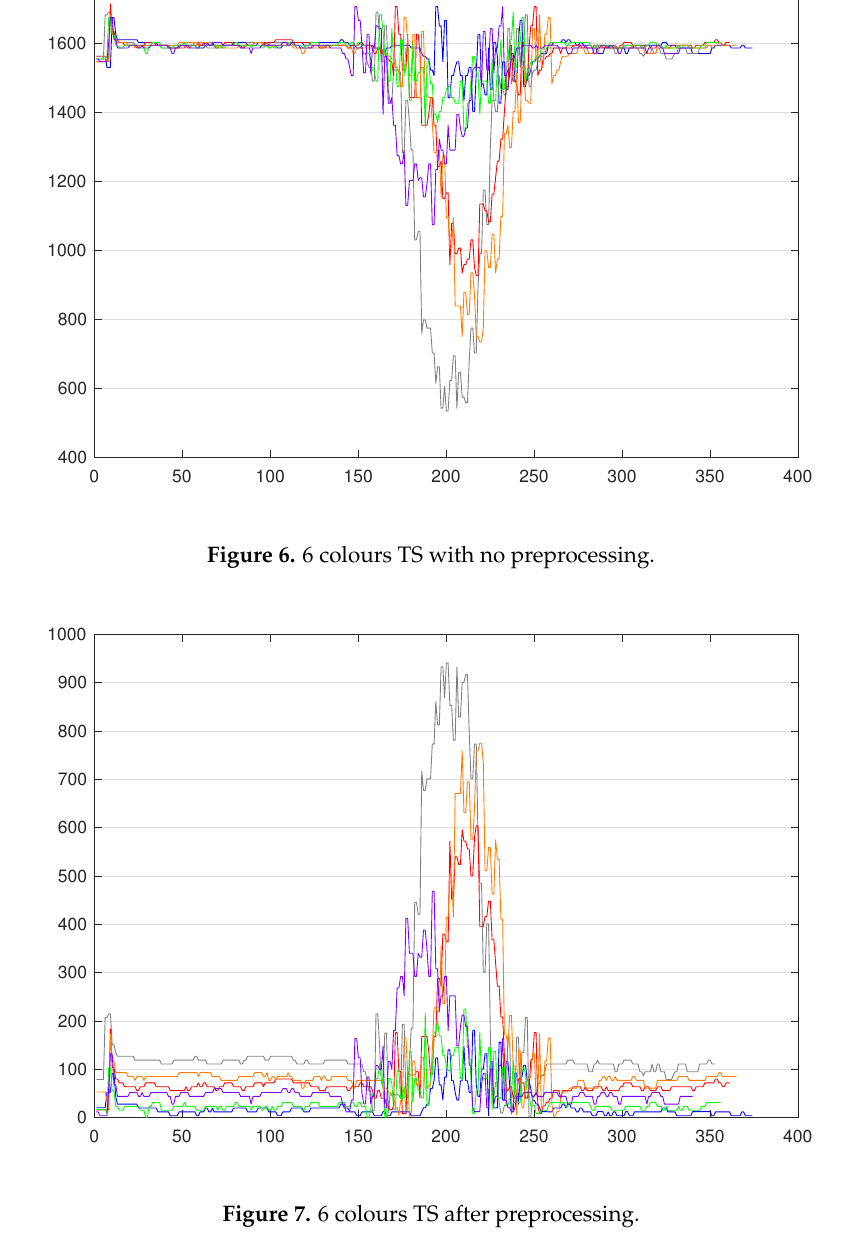
Figure 7. 6 colours TS after